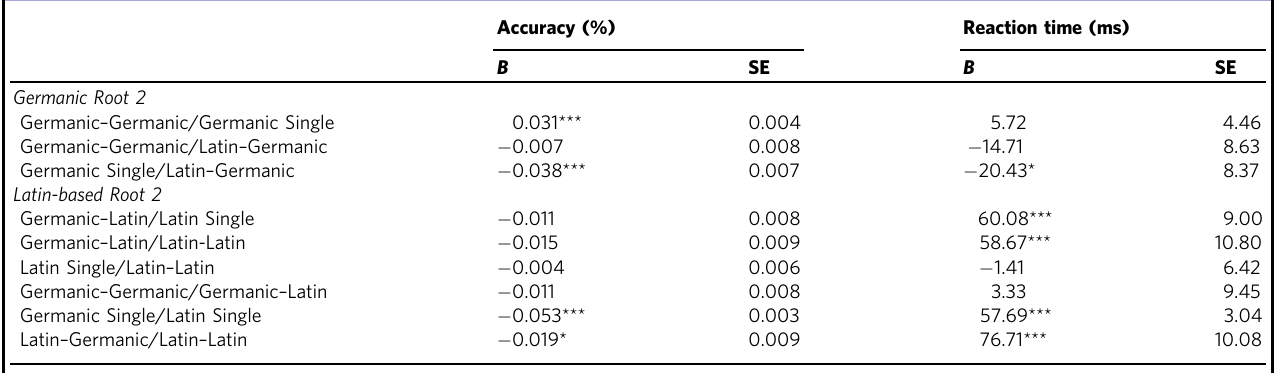
Table 7 English Crowdsourcing Project L2: simple effect/contrast analysis for lexical decision